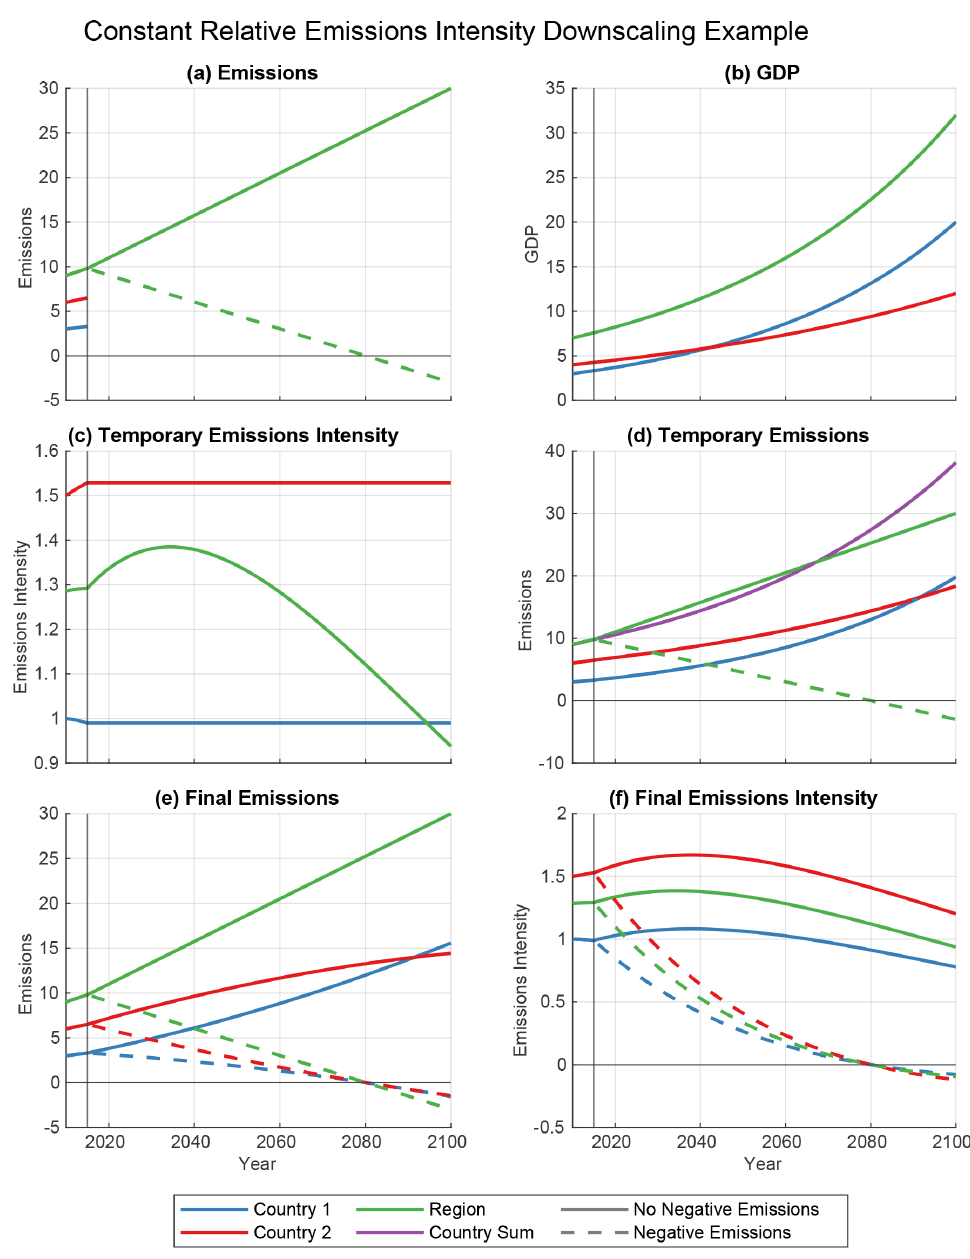
Figure D1. Steps of external-input-based downscaling of regional emission data using the IPAT equation and country GDP data explained using a two-country region. We use the assumption of constant relative emission intensities to enable the use of GDP as an external input for emission downscaling. Regional emission data are given for the whole time period, while for the countries only historical data are available (a) . GDP data are given for both countries and the region (b) for the whole time period. In the first step temporary emission intensity pathways for the countries are calculated using a constant extrapolation of historical values (2015) (c) . Multiplication with the given GDP time series creates temporary emission time series. These do not sum up to the regional value (see d ) and have to be scaled to the regional value (results in e ). This also changes the emission intensities (f)